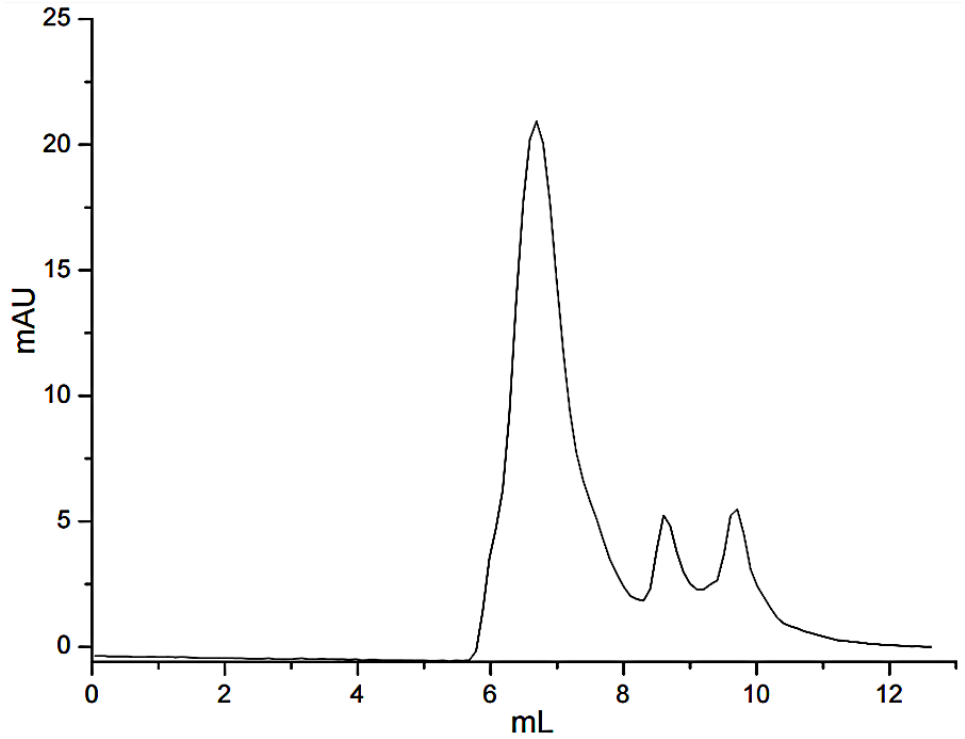
Figure 2. Gel filtration chromatograms of the desalinated peptide fraction.